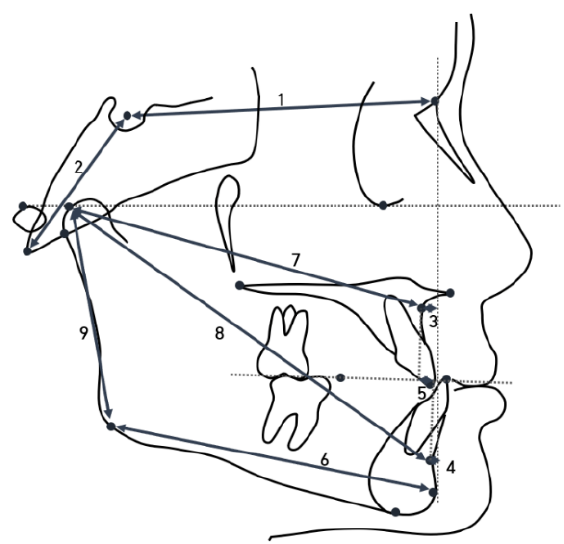
Figure 2. Linear measurements used in this study. 1, anterior cranial base; 2, posterior cranial base; 3, A point to N perpendicular; 4, pogonion to N perpendicular; 5, intermaxillary position to occlusal plane; 6, mandibular body length; 7, midfacial length; 8, mandibular length; and 9, mandibular ramus height.